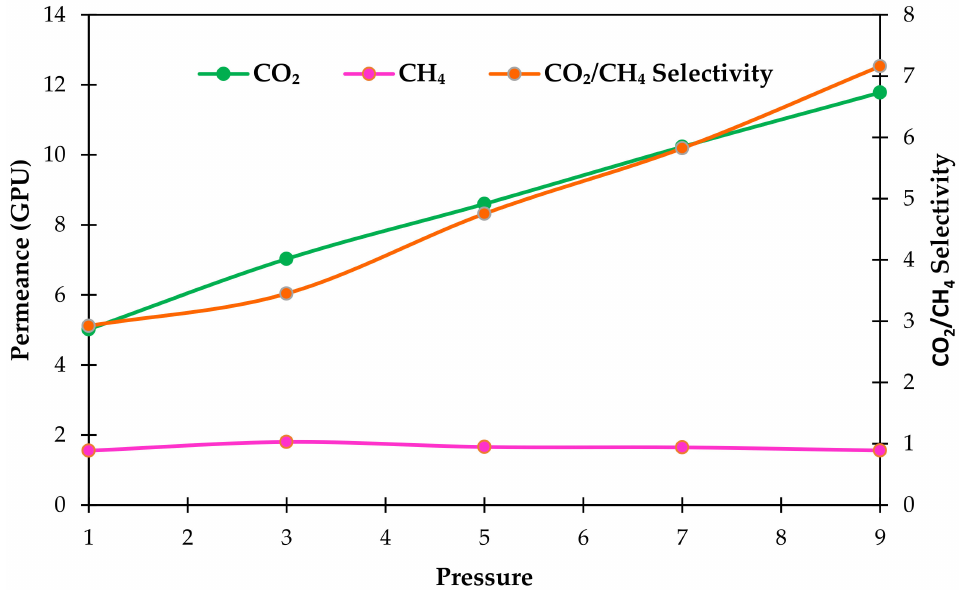
Figure 7. Effect of pressure on CO 2 and CH 4 permeances and CO 2 /CH 4 mixed gas selectivity in mixed gas separation at 42.5 vol % CO 2 feed